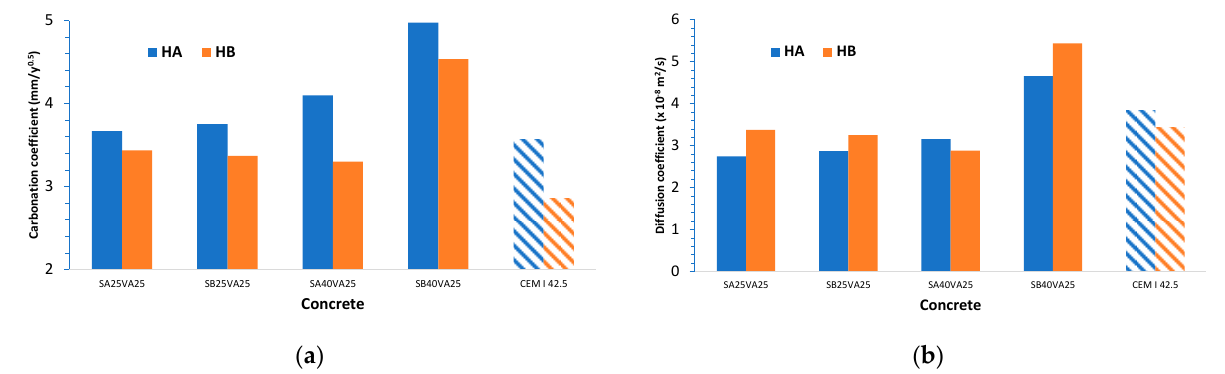
Figure 6. Input data for carbonation service life estimation for reinforced concrete structures exposed to atmospheric environment: ( a ) carbonation coefficient (mm/year 0.5 ); ( b ) carbonation diffusion coefficient ( × 10 − 8 m 2 /s).